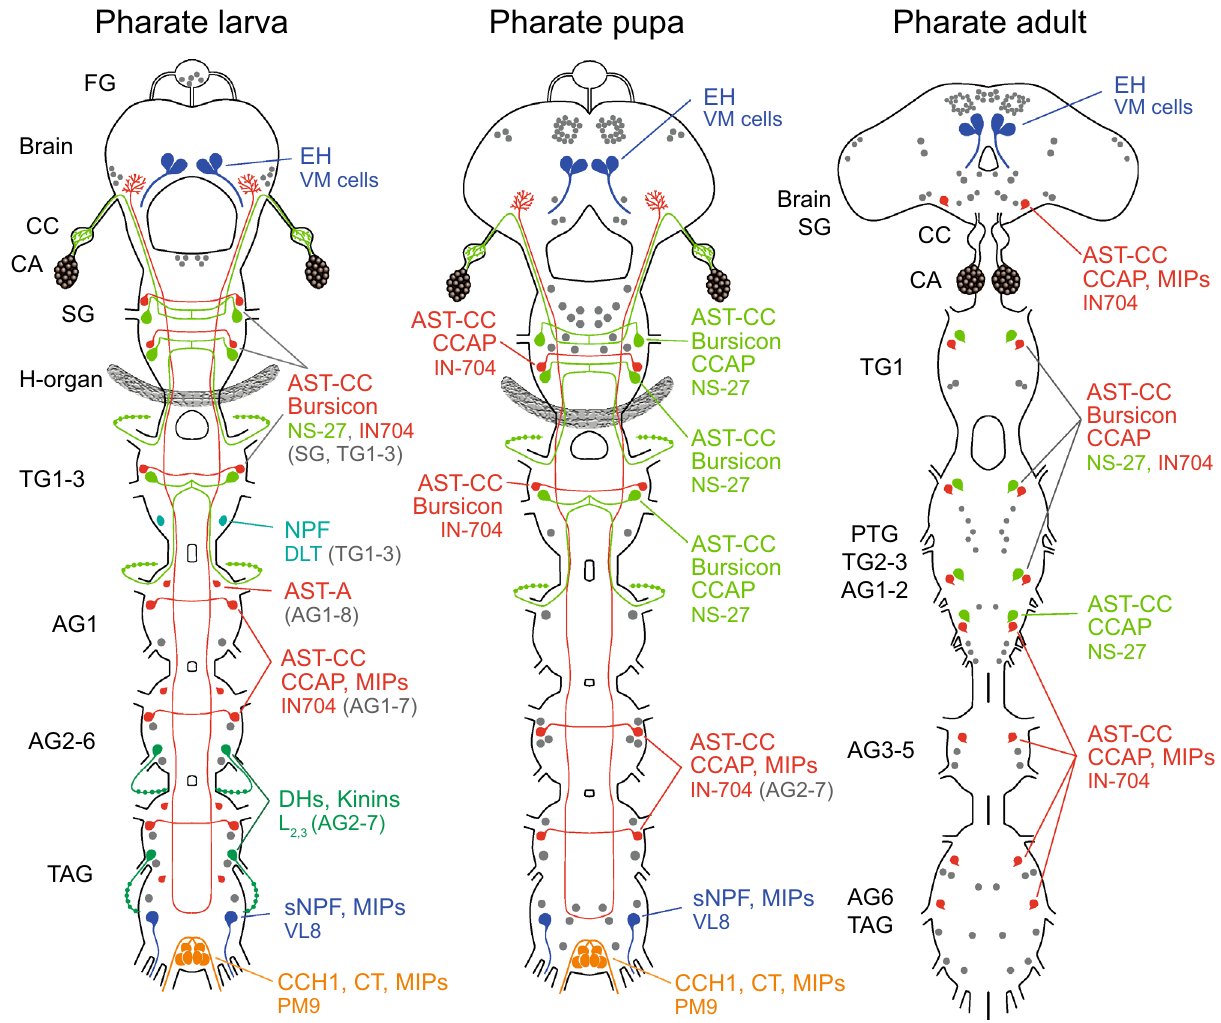
Figure 6. Schematic drawings depicting changes of ETHR-A expression in the CNS, CA and H-organ of pharate larvae, pupae and adults. Most larval ETHR-A neurons produce a large array of neuropeptides. However, number of peptidergic neurons decreased during metamorphosis and newly differentiated neurons in pharate pupae and adults do not seem to produce any known neuropeptide(s). Each identified type of peptidergic neuron is labelled by different color, while remaining unidentified ETHR-A neurons are labelled grey. Note very strong and consistent expression of ETHR-A in the CA and H-organ. The latter organ disappears after